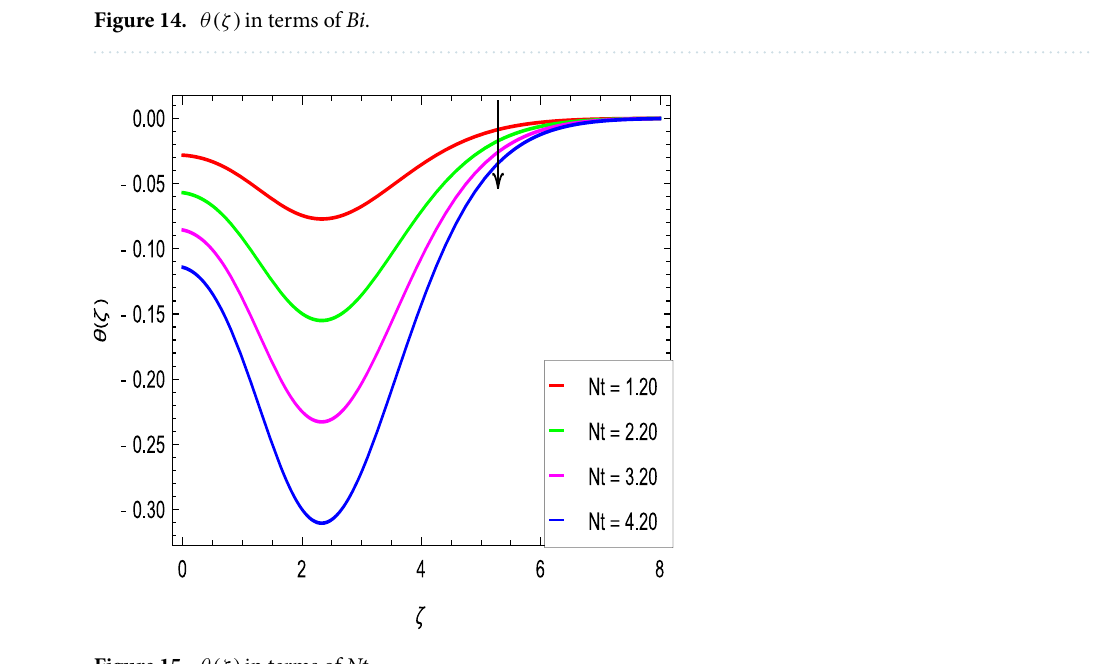
Figure 15. θ(ζ) in terms of Nt